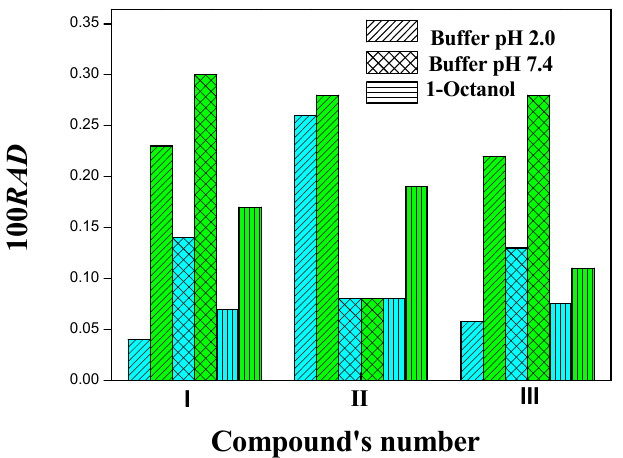
Figure 5. Comparative histogram of relative average deviations for used models: modified Apelblat equation—blue colour, van‘t Hoff equation—green colour.